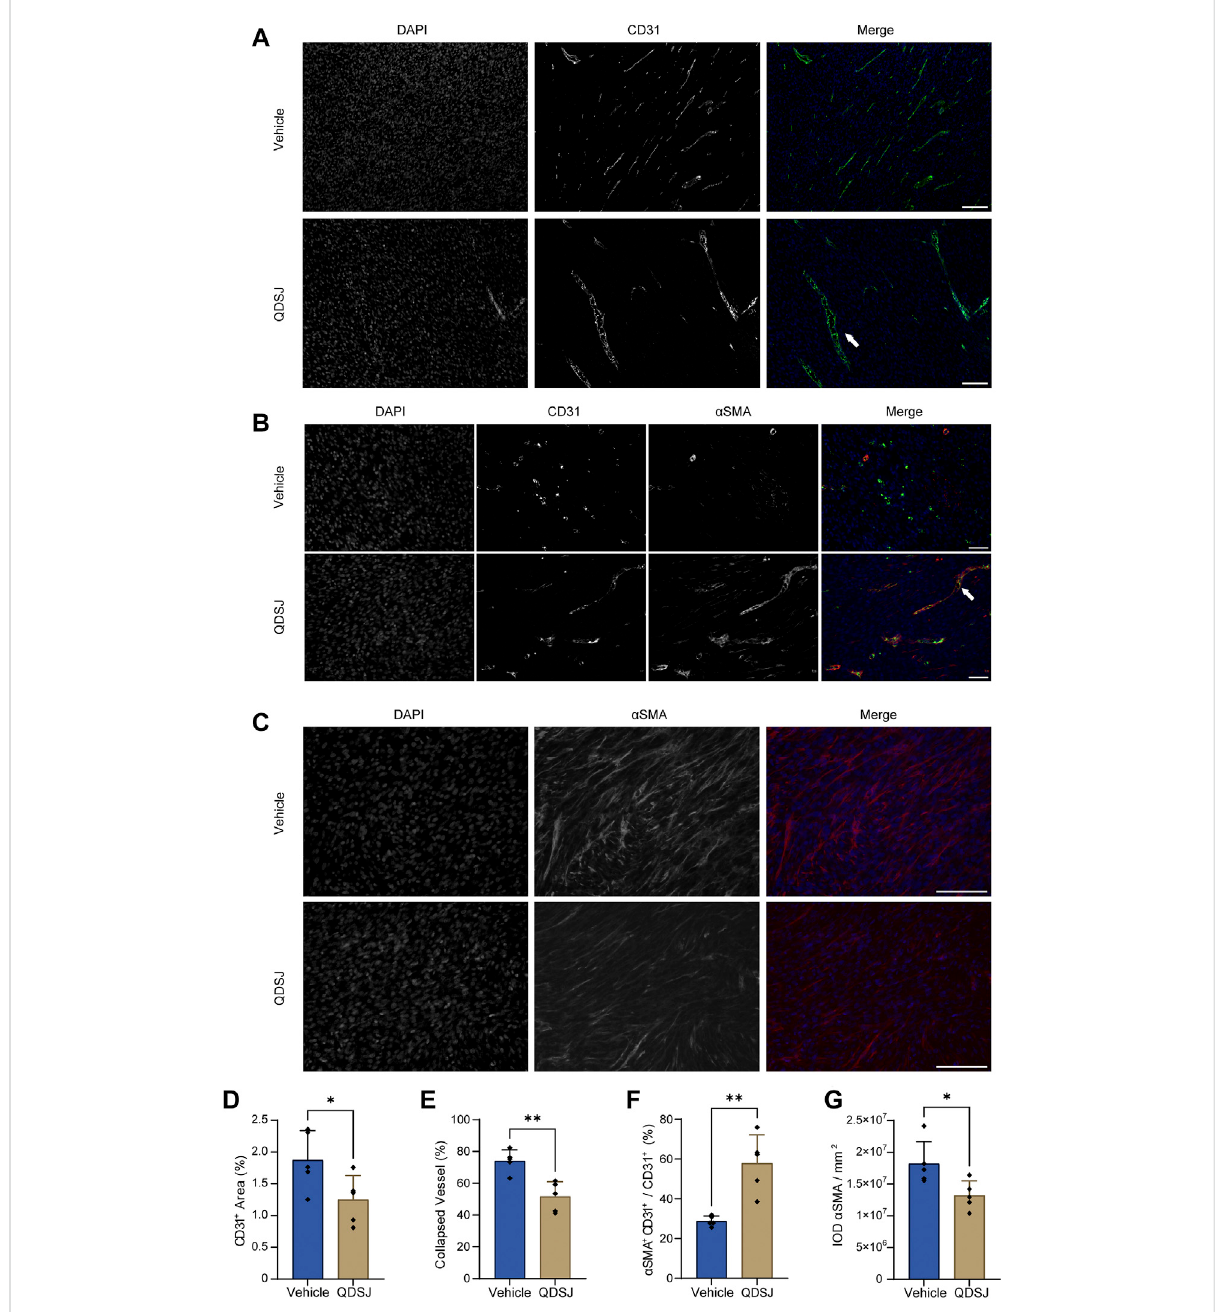
FIGURE 5 Treatment with QDSJ decoction reduces the number and density of vessels and normalizes vessel structure in schwannoma. (A – C) Representativeimmuno fl uorescencestainingofCD31(anendothelialcellmarker,green)and α SMA(apericyteand fi brosismarker,red)inQDSJ-and vehicle-treated tumors. Enlarged vascular vessels (white arrow in A) and pericyte-covered vessels (white arrow in B) were observed in the QDSJ- treated tumors. The fraction of CD31-positive vessel area (D) , collapsed vessels (E) , pericyte-covered vessels (% α SMA+CD31+/CD31+) (F) and IOD of α SMA fl uorescence (G) were quanti fi ed byusing ImageJ software. Scale bar = 100 μ m (A – C) ; n = 5/group; means ± SDs; * p < 0.05, and ** p < 0.01 by Student ’ s t